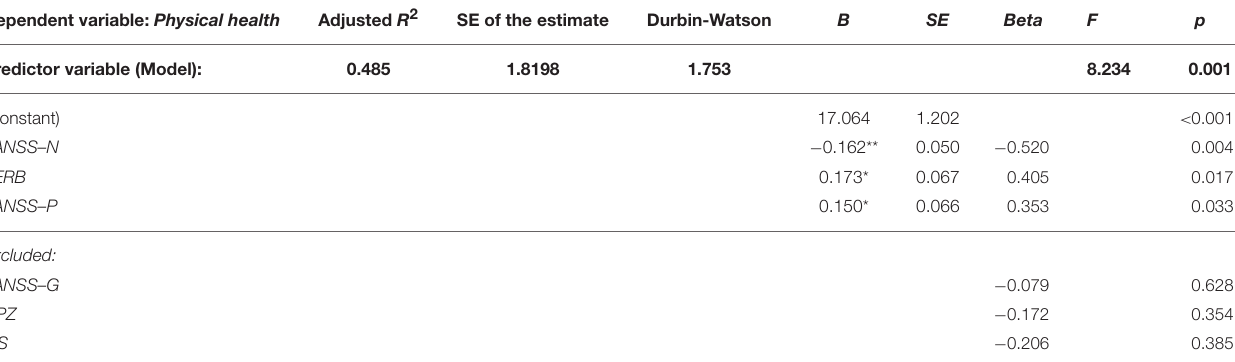
TABLE 6 | Regression model of clinical and neuropsychological variables (predictors) on perceived quality of Physical health (dependent variable). Dependent variable: Physical health Adjusted R 2 SE of the estimate